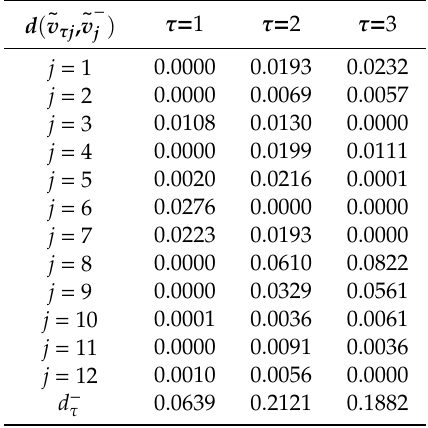
Table 14. Distance of each information system from